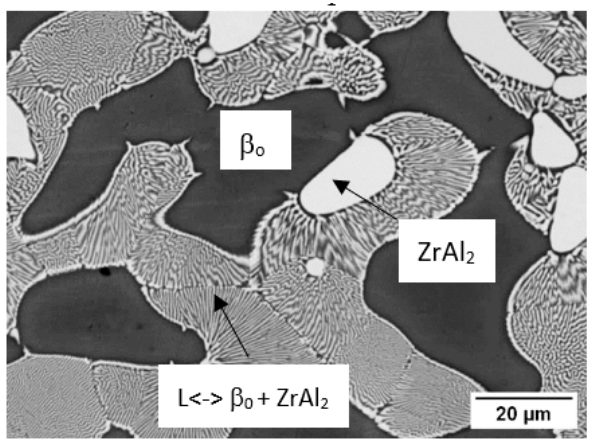
Figure 12. Microstructure at the outer edge of alloy Z4 (Ti-43.3Al-16.1Zr at. %) heat treated at 1300 °C/24 h.